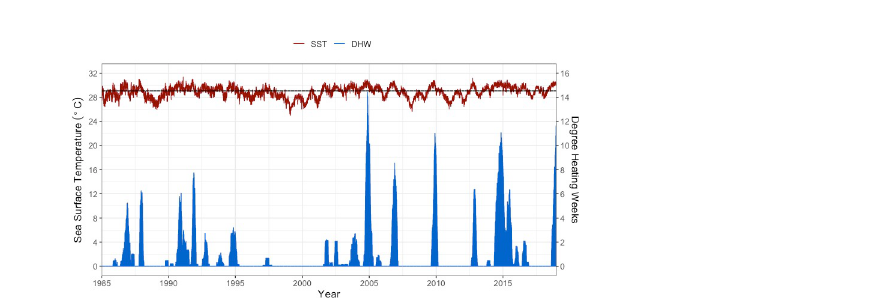
Fig 2. Daily sea surface temperature (red), Degree Heating Weeks (blue) averaged across study sites from 1985 through 2018, with the maximum monthly mean (black).